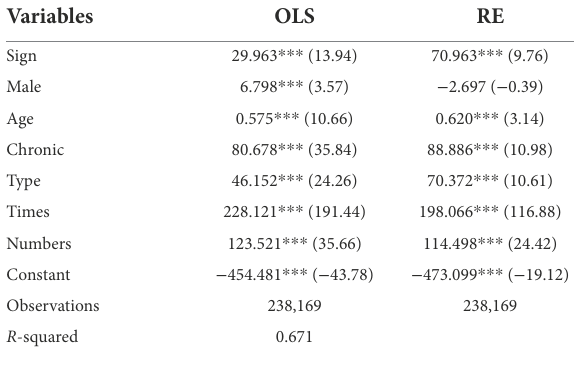
TABLE 3 The regression result of model